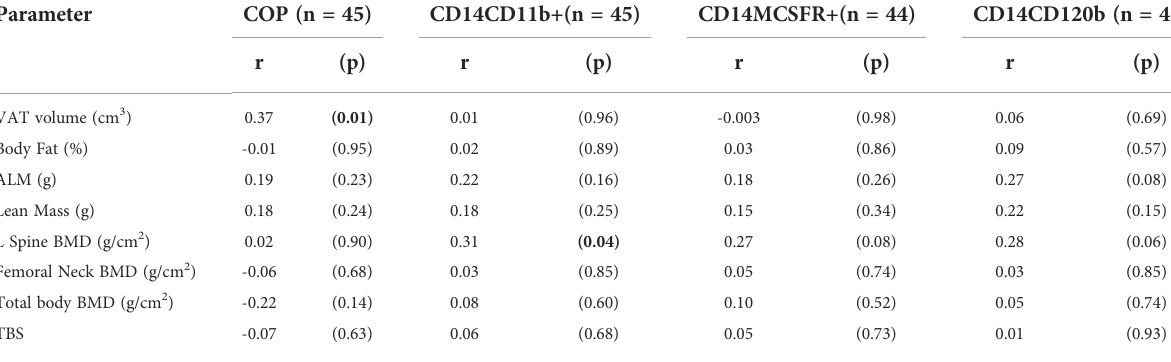
TABLE 4 Correlation analysis of body composition parameters on circulating osteogenic progenitors and osteoclast precursors.